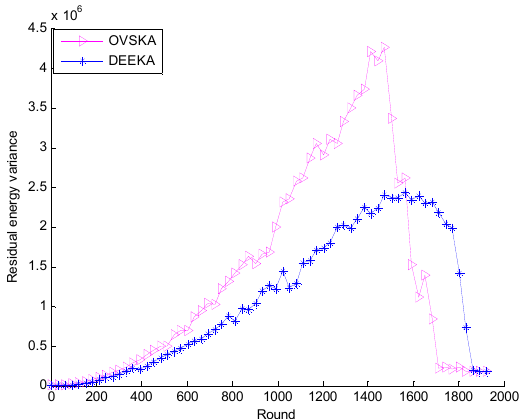
Figure 11. Residual energy variance with the number of network running rounds.